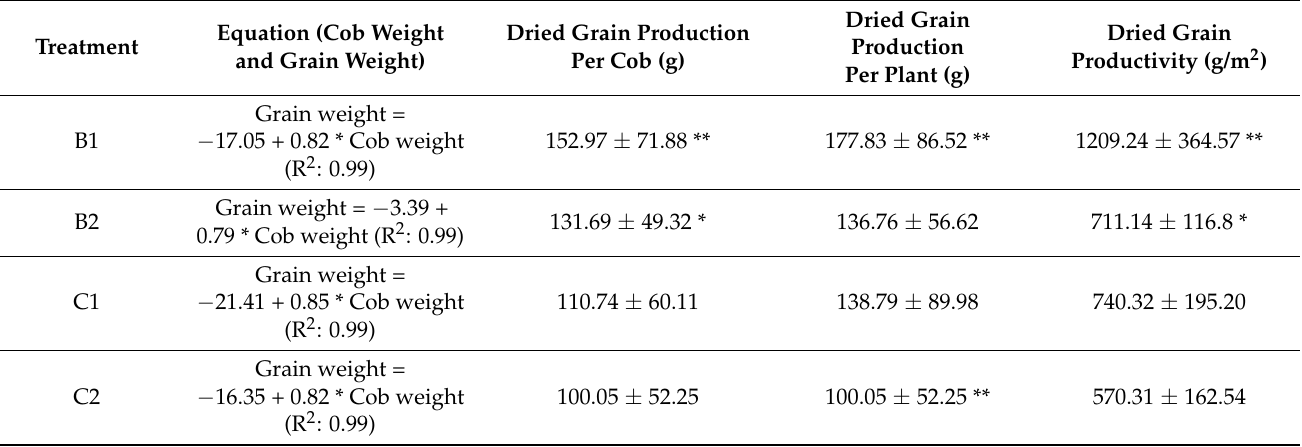
Table 5. Production data, dry weight and yield per square meter. Data are represented as mean ± standard deviation. Control: plots without biochar; B1: plots supplemented with biochar B1; B2: plots supplemented with biochar